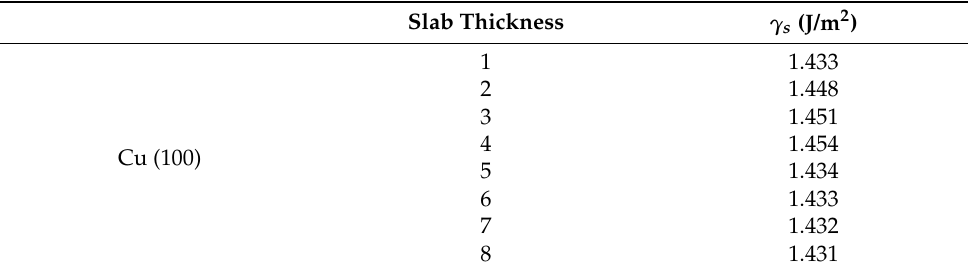
Table 2. The surface energy as a function of slab thickness.